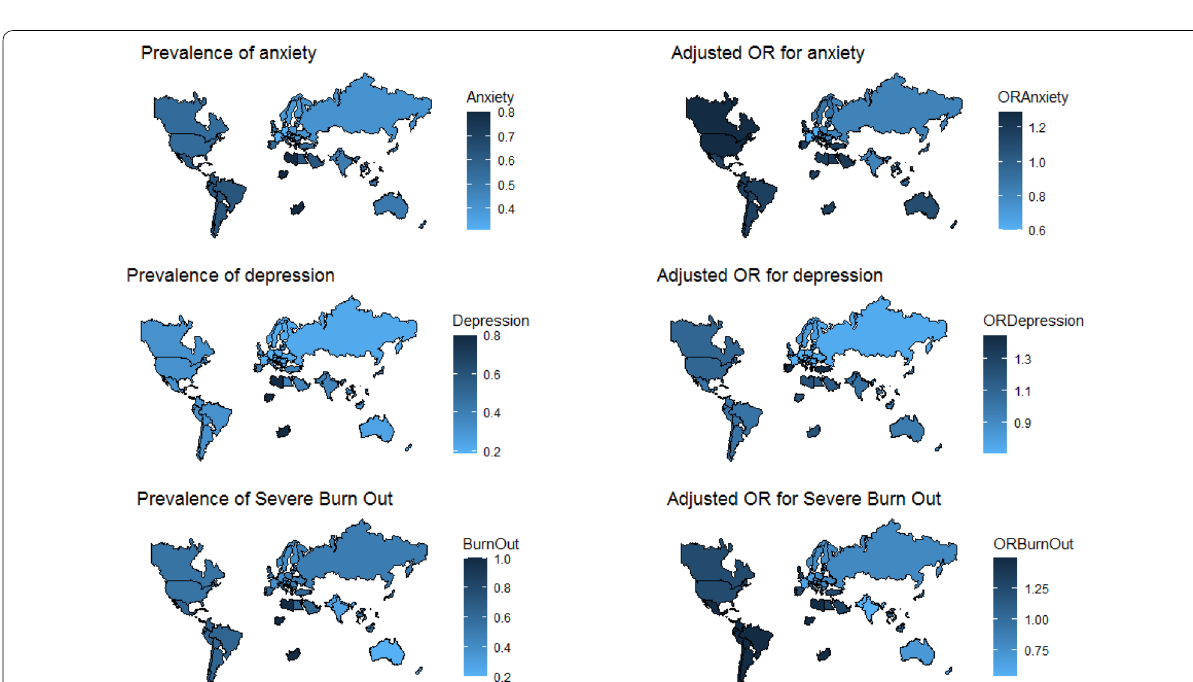
Fig. 5 World map displaying the prevalence (graphs in the left) and the adjusted odds ratio (OR, graphs in the right) of symptom of anxiety, depression and severe burnout across